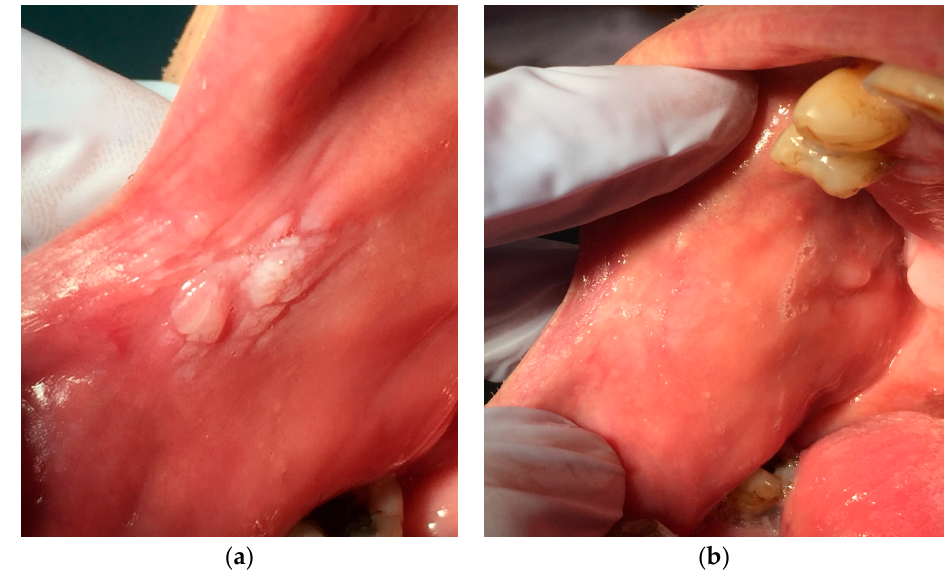
Figure 5. ( a ) Hyperkeratosis during the first visit: the area appears whitish and irregular, ( b ) The same area four weeks after treatment. Int. J. Environ. Res. Public Health 2018 , 15 , x